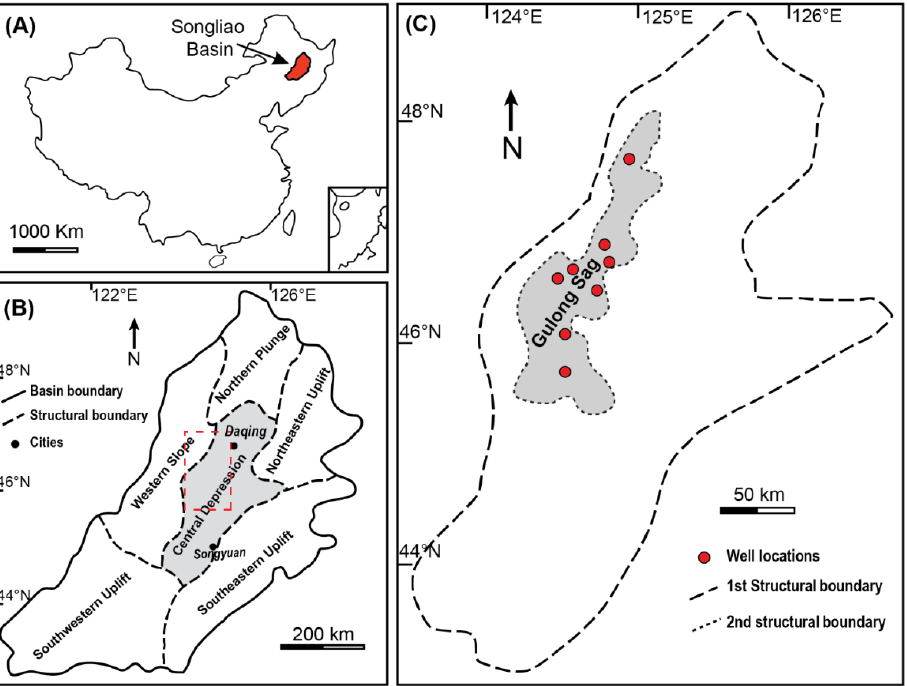
Figure 2. Geological Maps showing the study area (modified from Liu et al. 2019 [44]). ( A ) Location of Songliao Basin. ( B ) Tectonic divisions of the Songliao Basin Central depression, with a shaded area representing the central depression. The red square denotes the study area in Figure 2C. ( C ) The 1st-order structural boundary outlines the central depression, and the 2nd-order structural boundary constraints Gulong Sag (shaded area); studied wells are shown in red circles.